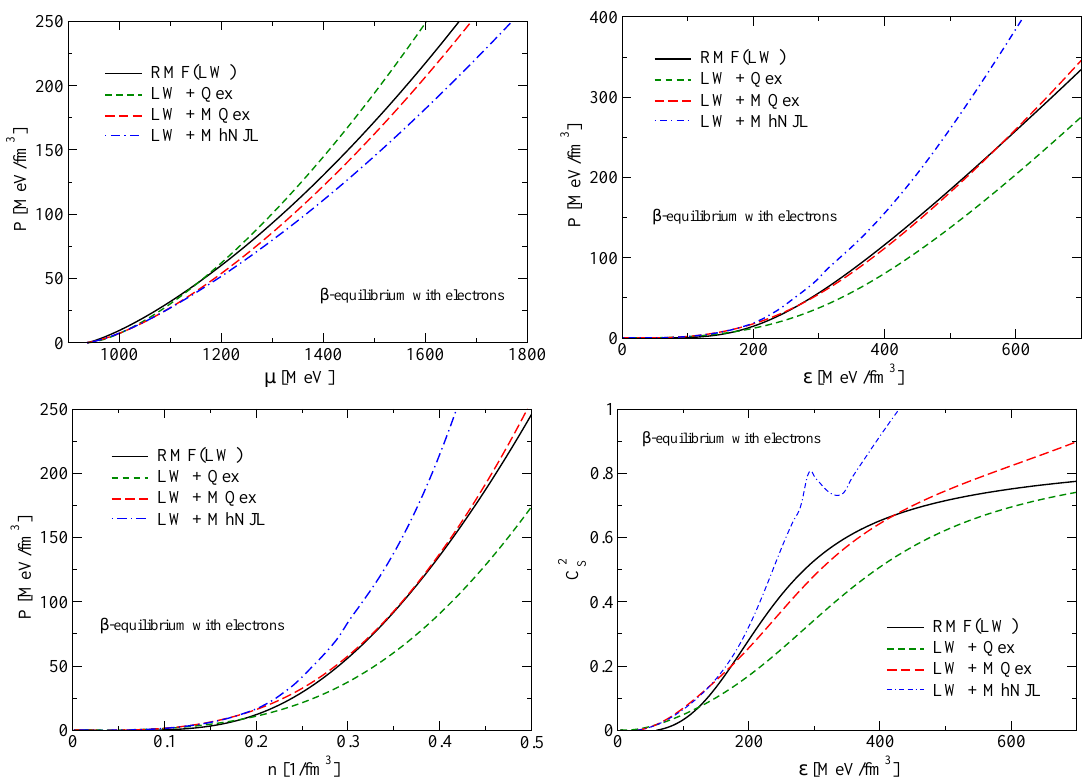
Figure 9. EoS in β -equilibrium with electrons for all considered models. Clockwise: pressure as function of baryo-chemical potential µ ; pressure as function of baryon density n = dP / d µ ; squared speed of sound c 2 s = dP / d ε ; pressure as function of energy density ε = − P + µ n